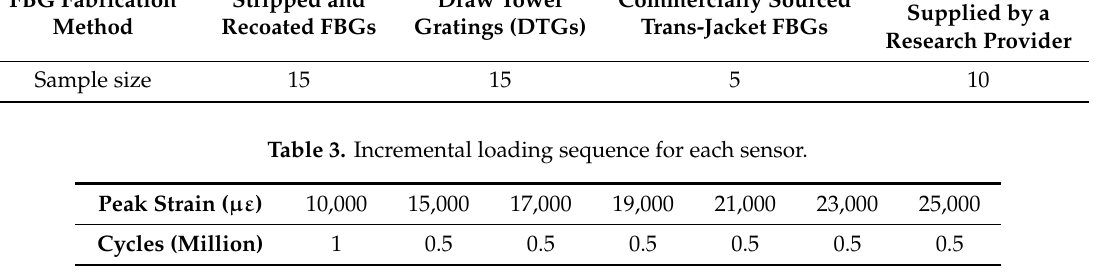
Table 3. Incremental loading sequence for each sensor.